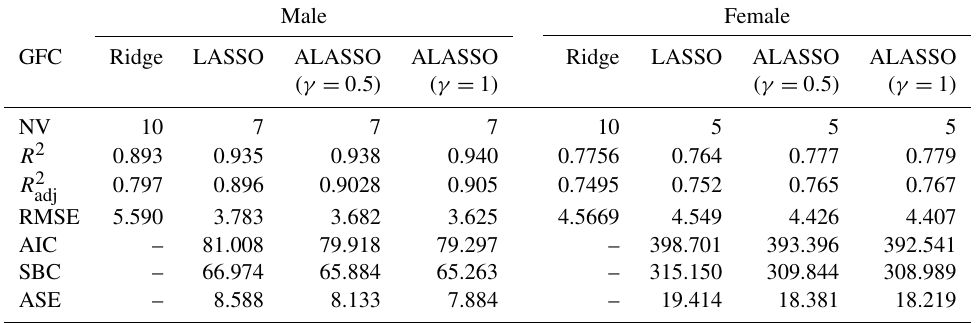
Table 5. Goodness-of-fit criteria for estimation equations of Ridge, LASSO, and ALASSO ( γ = 0 . 5 and γ = 1) for male and female goats. Male Female GFC Ridge LASSO ALASSO ALASSO Ridge LASSO ALASSO ALASSO ( γ = 0 . 5) ( γ = 1) ( γ = 0 .